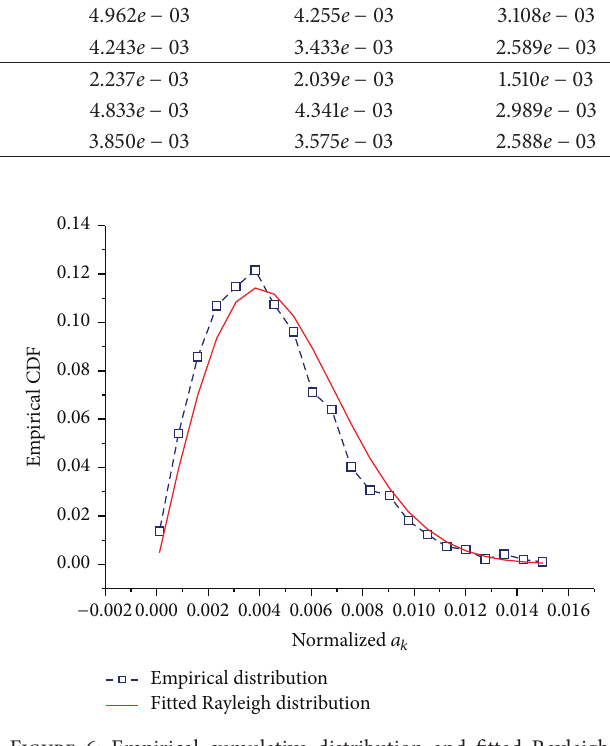
Figure 6: Empirical cumulative distribution and fitted Rayleigh distribution of the 𝑎 𝑘 in Group 4 at 1.8 GHz in Scenario